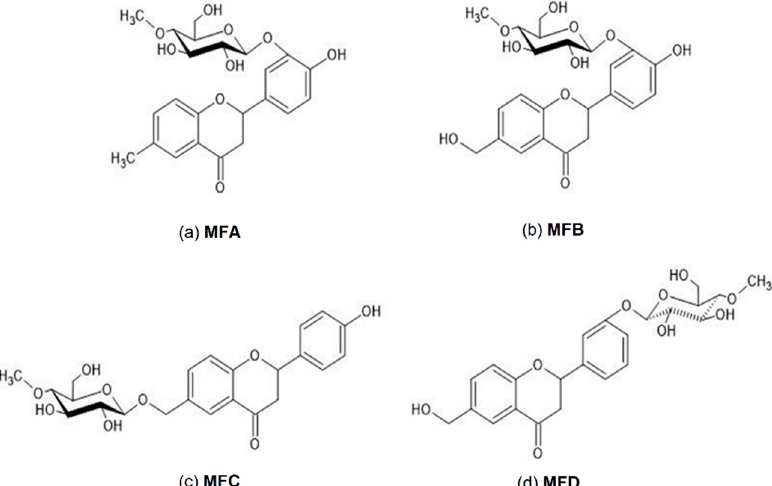
Figure Figure 1. The structures of studied 6-methylflavanone biotransformation products: ( a ) 4 ′ -hydroxy- 6-methylflavanone 3 ′ -O- β -D-(4 ′ ’-O-methyl)-glucopyranoside (MFA); ( b ) 4 ′ -hydroxy-6- hydroxymethylflavanone 3 ′ -O- β -D-(4 ′ ’-O-methyl)-glucopyranoside (MFB); ( c ) 4 ′ -hydroxyflavanone 6-methylene-O- β -D-(4 ′ ’-O-methyl)-glucopyranoside (MFC); ( d ) 6-hydroxymethylflavanone 3 ′ -O- β - D-(4 ′ ’-O-methyl)-glucopyranoside (MFD).